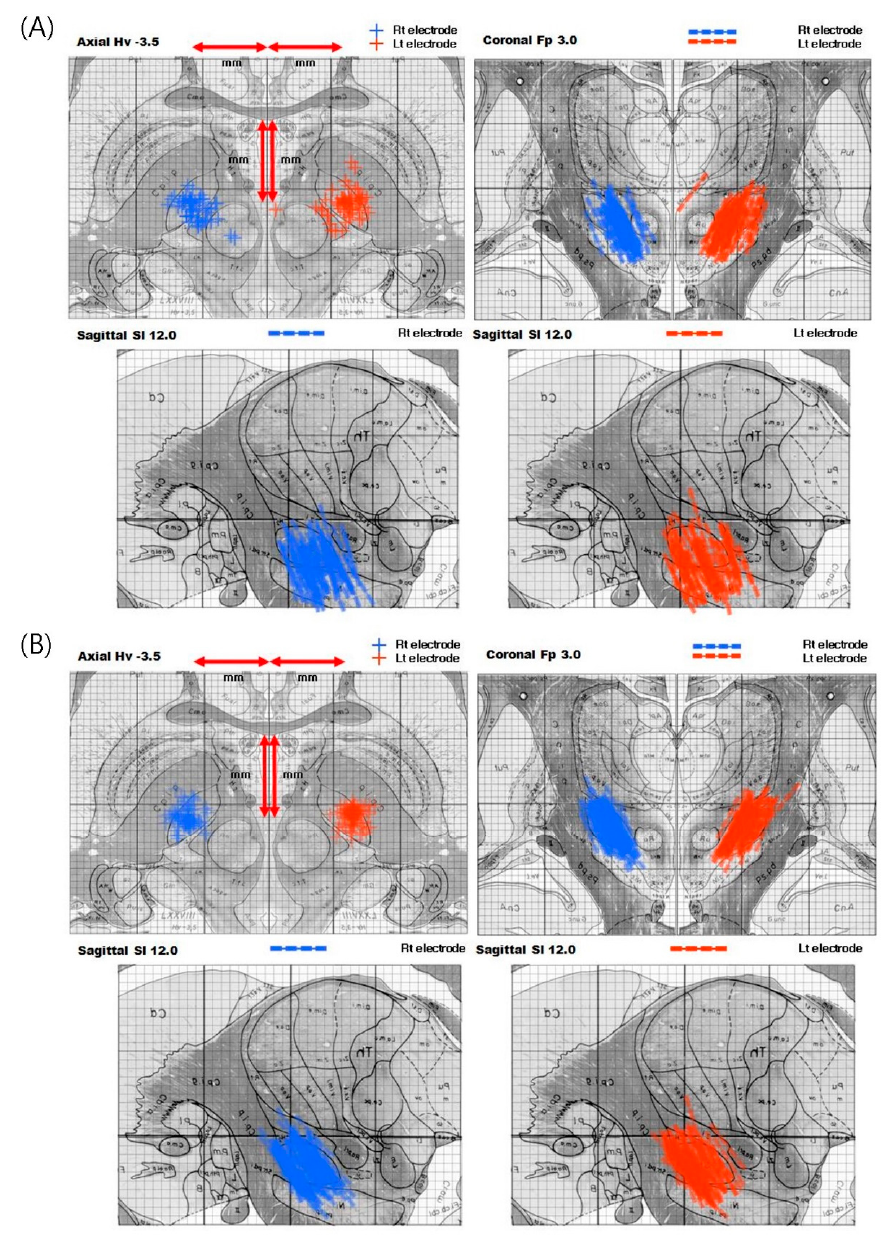
Figure 2. Plotting of the electrode location based on the plotted position of the electrode in the axial view which is 3.5 mm below the anterior commissure (AC)–posterior commissure (PC) line in the human brain atlas of Schaltenbrand and Wahren. ( A ) Local anesthesia (LA) cohort, ( B ) General anesthesia (GA) cohort. Compared to LA cohort, the GA cohort showed a higher tendency for the electrode to be located within the subthalamic nucleus (STN).